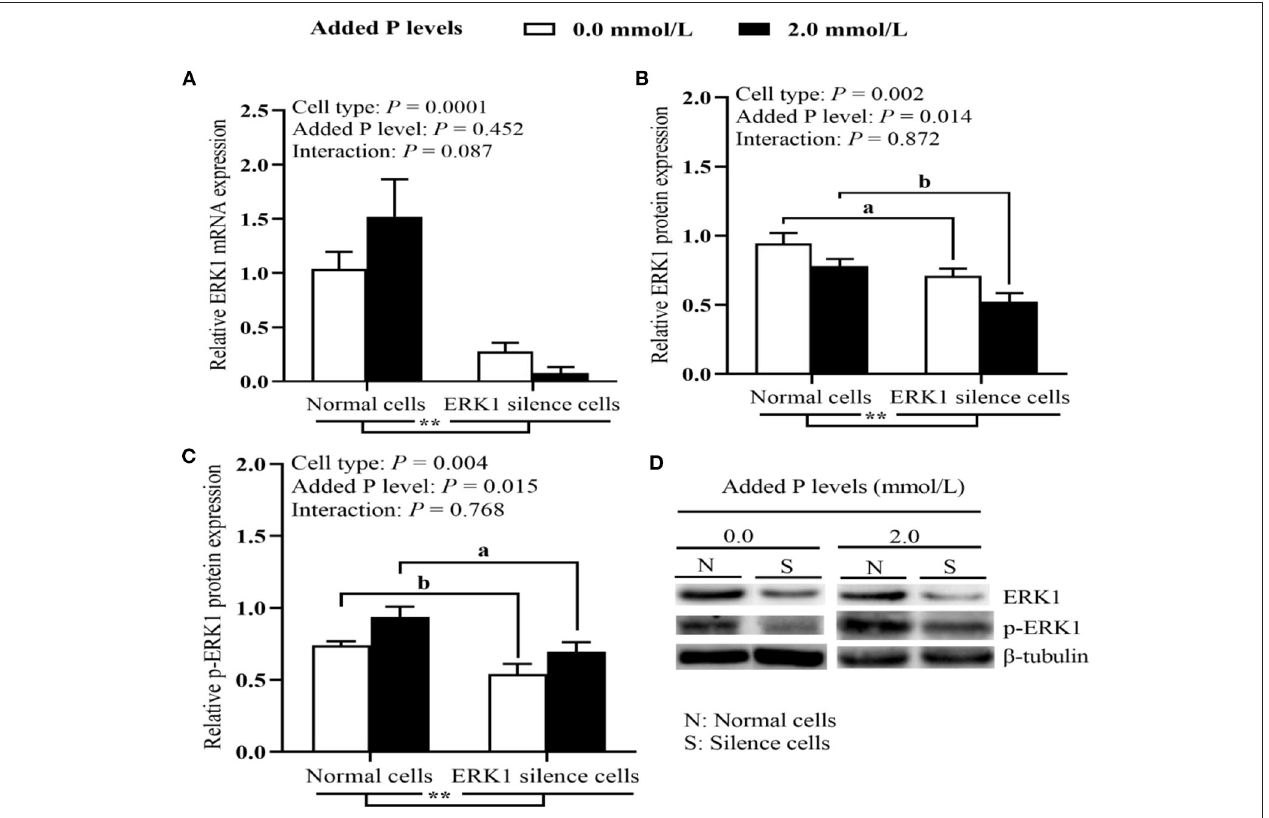
FIGURE 5 | Effects of cell types and P levels on the tibial osteoblastic ERK1 mRNA (A) , ERK1 and p-ERK1 protein expressions (B–D) in primary broiler osteoblasts (experiment 2). Each value represents the means ± SE, n = 4. Lacking the same letters (a, b) means significant differences, P < 0.05. ** P < 0.01. ERK, extracellular signal-regulated kinase 1; P,